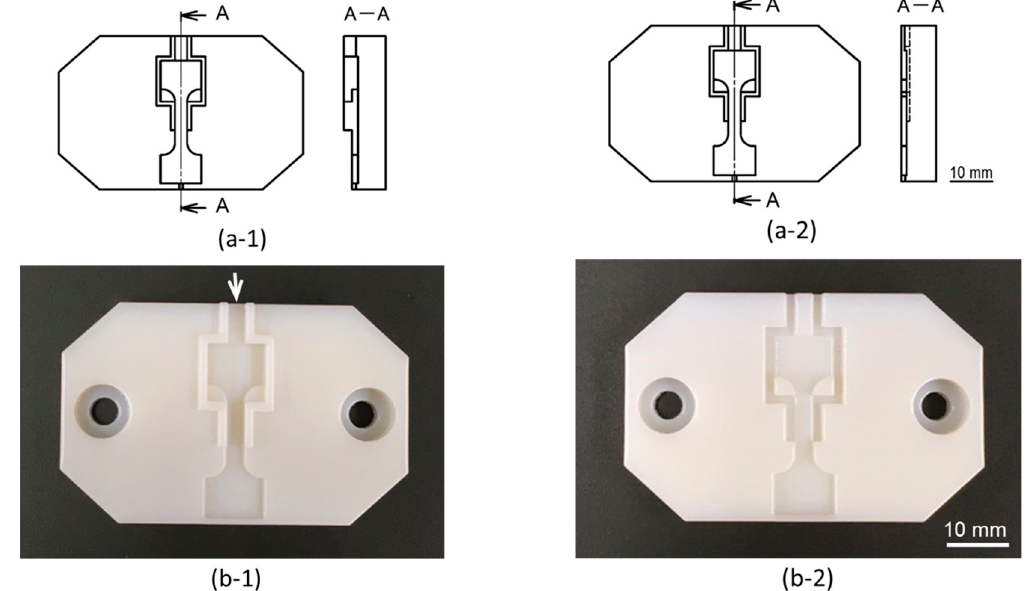
Figure 3. ( a ) A schematic representation of the two parts of the mold for injection molding (I.M.) for test piece fabrication. ( a-1 ) upper part and ( a-2 ) lower part. ( b ) Photograph of the two parts of the mold fabricated using a rapid prototyping system. ( b-1 ) upper part and ( b-2 ) lower part. The arrow in ( b-1 ) indicates the direction of the melted polymer flow.